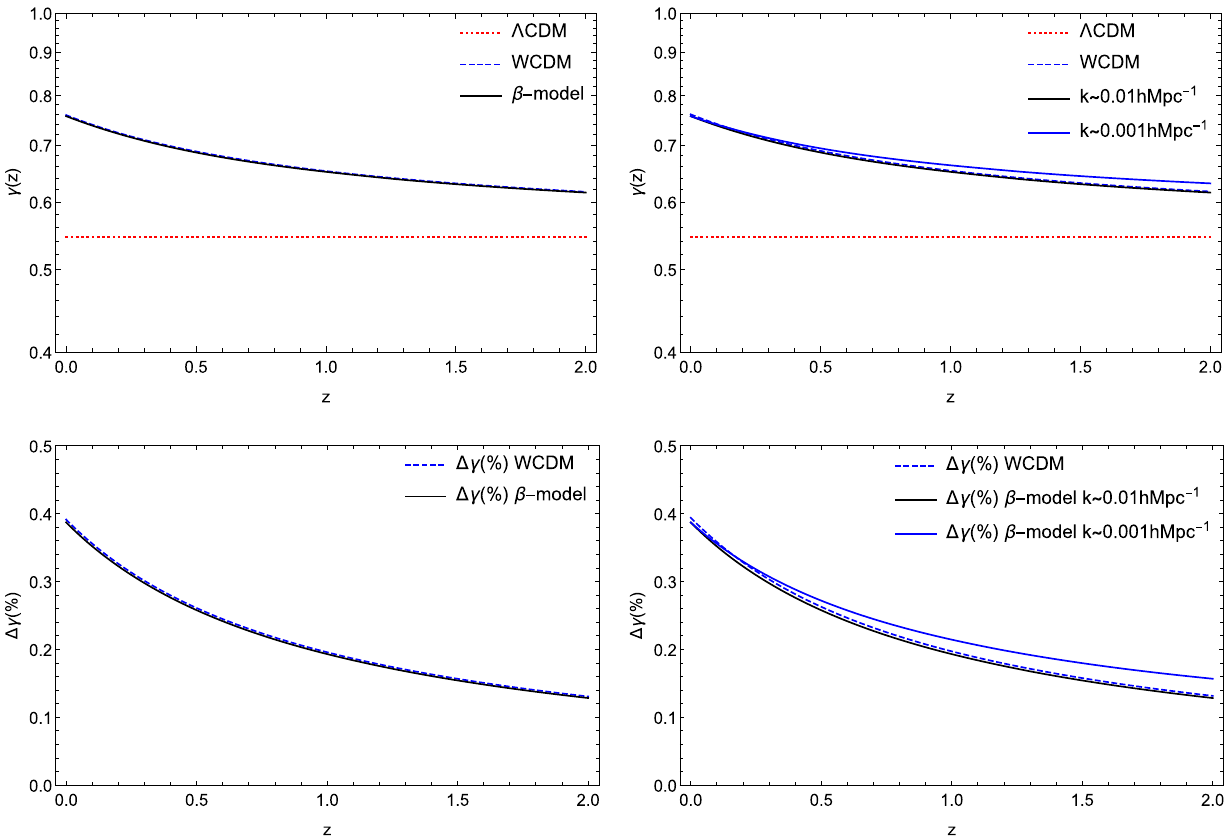
Fig. 2 Growth index evolution in different scales (top panels). In the bottom panels, the percentage difference is presented. Λ CDM is considered as a reference model. The values of the parameters were extracted from Tables 2 and 4